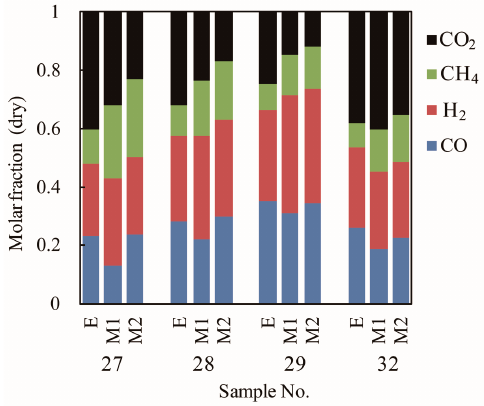
Figure 6. Comparison between experimental data and predicted data based on different models for syngas composition (E-experimental data, M1-model with tar, M2-model without tar).